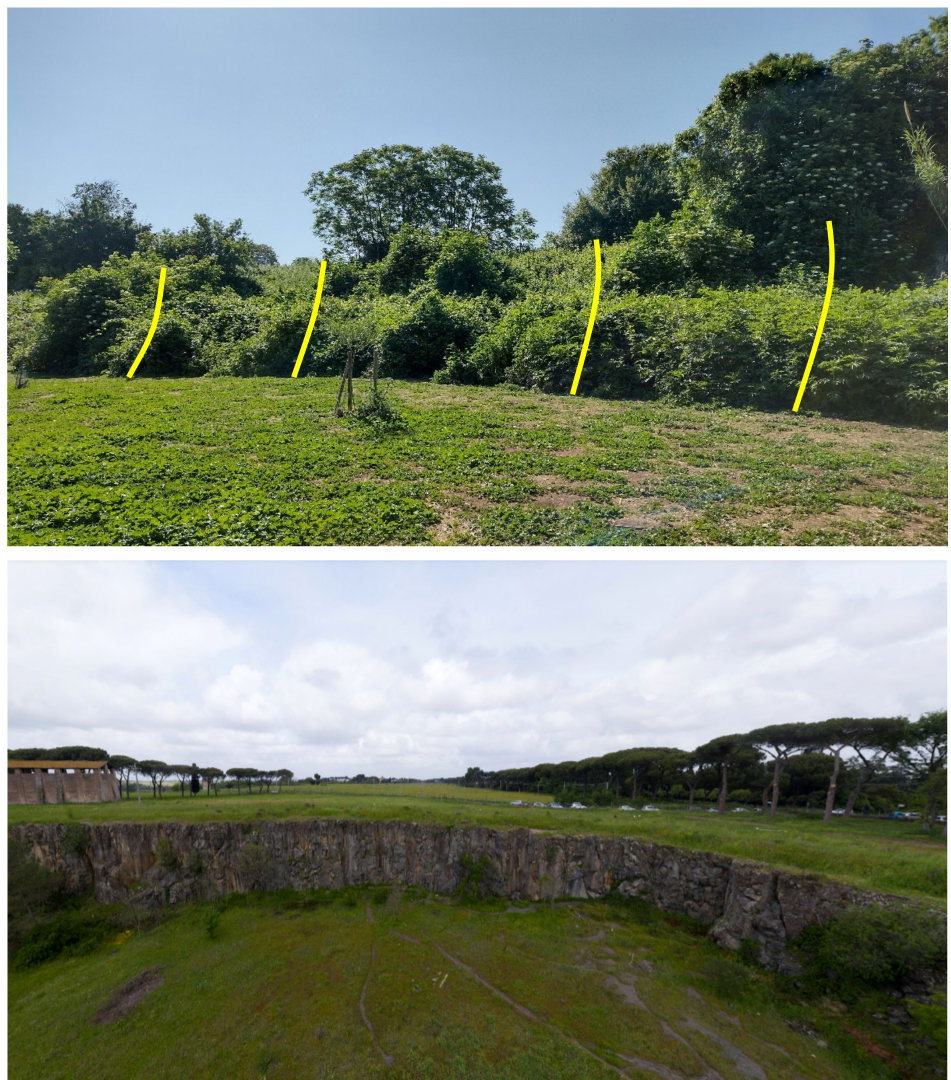
Figure 8. Mines: abandoned mine of Pozzolana located near the Latina street (northeast of the park); its slope (yellow lines) is covered by natural vegetation (top photo); mine Cava di Fioranello of basalt, near Ciampino airport, south of the park (bottom